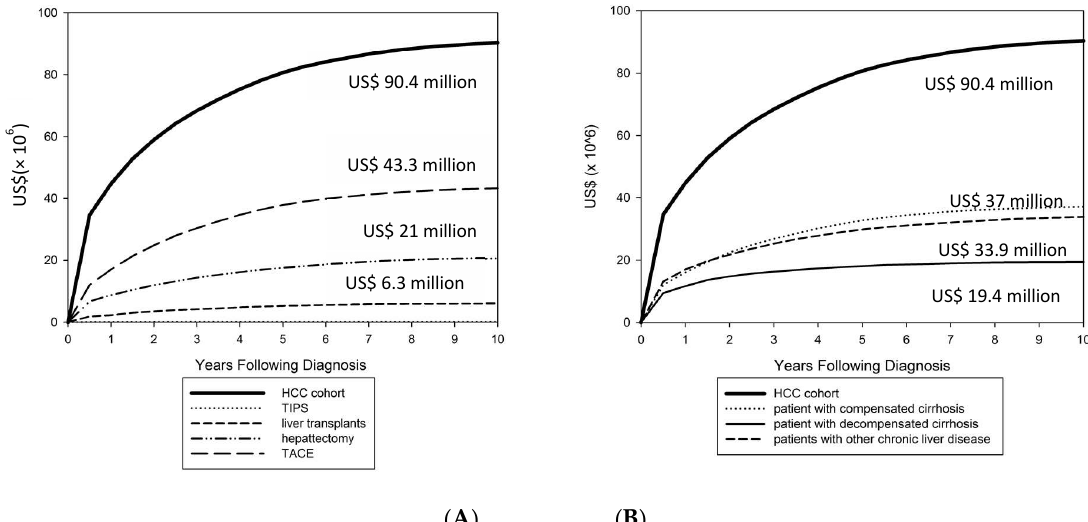
Figure 2. The 10-year cumulative costs for HCC patients by surgical intervention ( A ) and by stage of liver disease ( B ). US$90.4 million (90,377,380) for the entire HCC cohort; US$43.3 million (43,296,479) for patients received TACE procedures; US$21million (20,600,273) for hepatectomy; US$158,068 for TIPS; and US$6.3 million (6,294,255) for liver transplantation; US$37 million (37,102,854) for compensated cirrhosis; US$33.9 million (33,862,713) for other liver disease; US$19.4 million (19,411,813) for with decompensated cirrhosis.